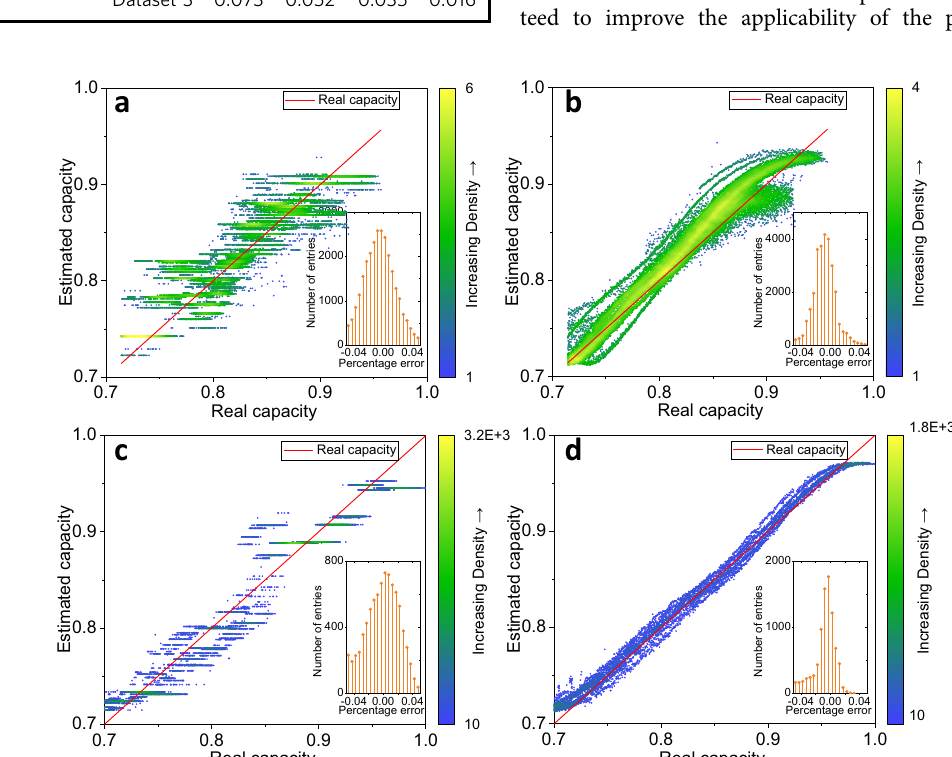
Fig. 6 Test results of estimated capacity versus real capacity by transfer learning. The capacity results are uniformized by the nominal capacity for comparison. Results of TL2 embedding XGBoost method ( a ) and embedding SVR ( b ) on dataset 2. Results of TL2 embedding XGBoost method ( c ) and embedding SVR ( d ) on dataset 3. Additional results are disclosed in Supplementary Figs. 10 –